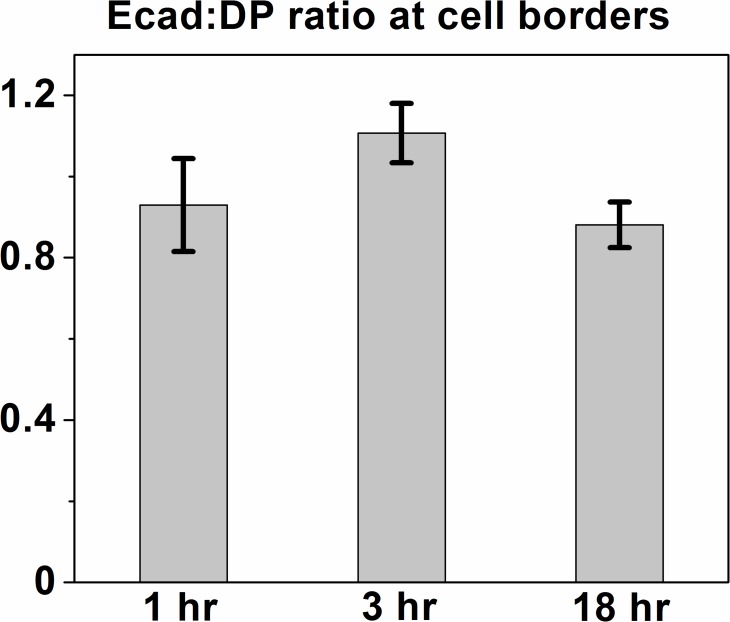
Relative Ecad levels remain unchanged over a calcium switch time-course.Quantification of Ecad:DP ratio at cell borders. Entire cell border regions (in contrast to individual desmosomes as for Figure 3) were selected using the polygon selection tool in Fiji and the mean intensity of Ecad was normalized to the mean intensity of DP within the border region of interest (defined by cadherin and DP presence) for the time points indicated. n = 17, 19 and 12 respectively. P>0.05 with Kruskal–Wallis, Dunn’s post hoc test. A nonparametric test was used as data did not pass D’Agostino–Pearson omnibus normality test.